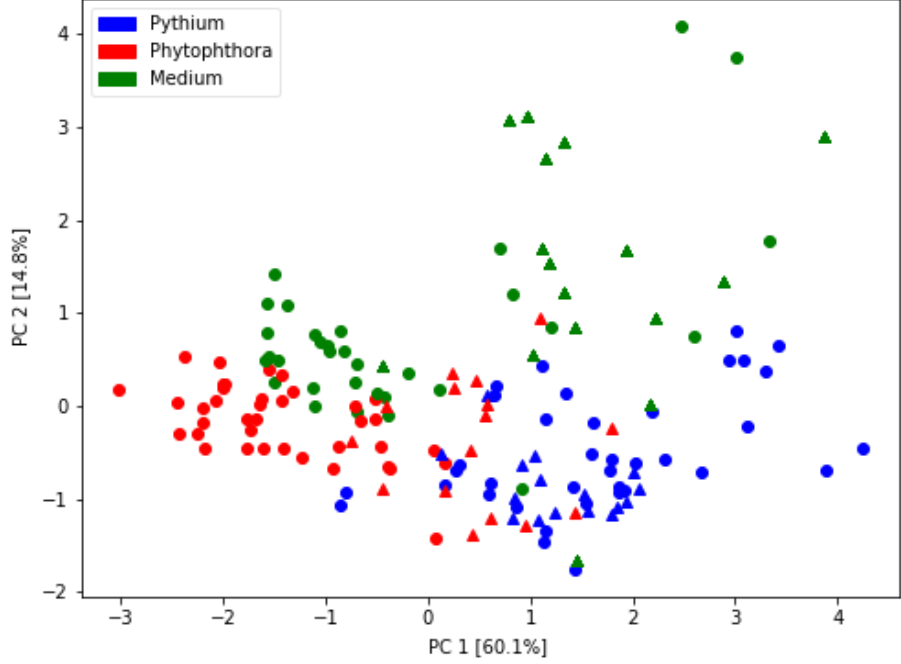
Figure 4. Visualization of measured samples distribution using Principal Component Analysis transformation of five features extracted from the sensor response curves. The principal components’ percentage of variability is indicated in the axes captions. Types of measured samples are plotted using various colors. As described in the text, data collected in two parts of the experiment are distinguished by different symbols: circles—the first part, triangles—the second